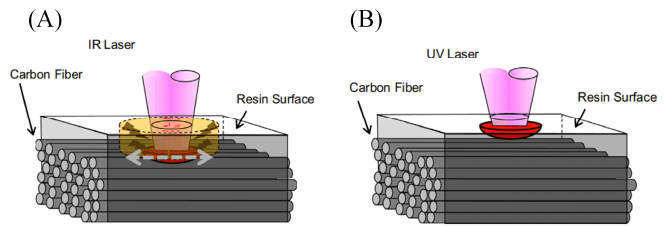
Figure 5. Laser cutting process of CFRP, which depends on the wavelength of the laser: ( A ) infrared laser and ( B ) UV laser processing CFRP mechanism [40].